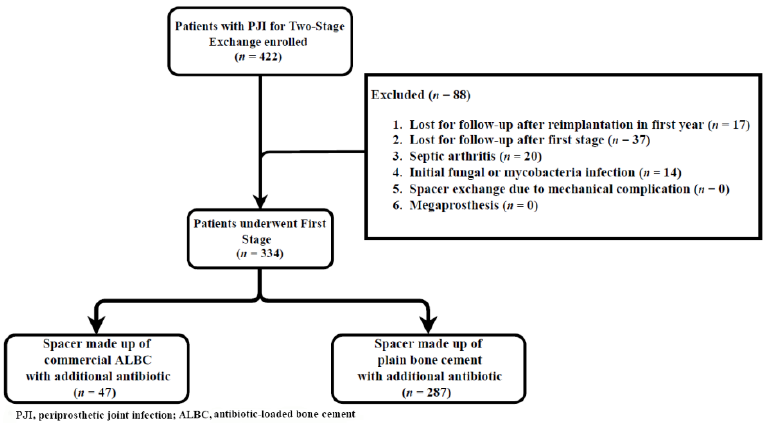
Figure 1. Diagram of patient enrollment and exclusion.